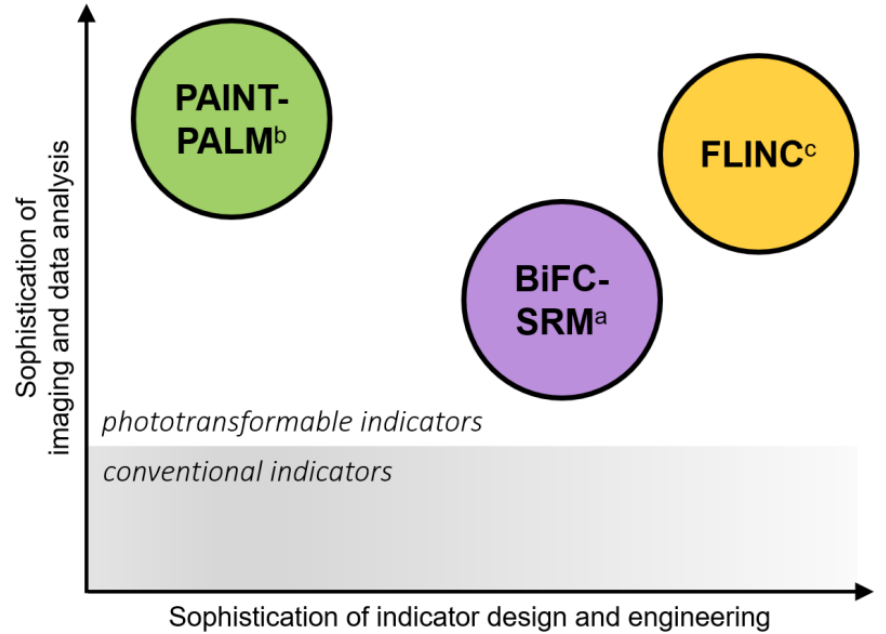
Figure 3. Accessibility of genetically encoded indicators derived from phototransformable fluorescent proteins for functional super-resolution imaging. a: BiFC-based indicators for SRM (BiFC-SRM)